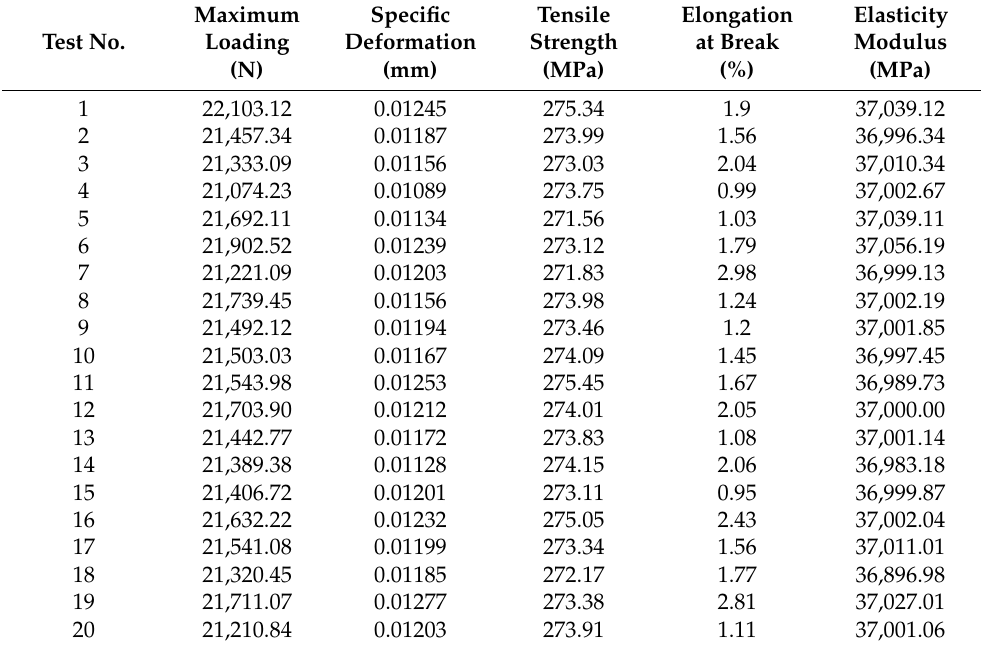
Table 1. Results obtained from the tensile tests of gray cast iron samples with lamellar graphite type